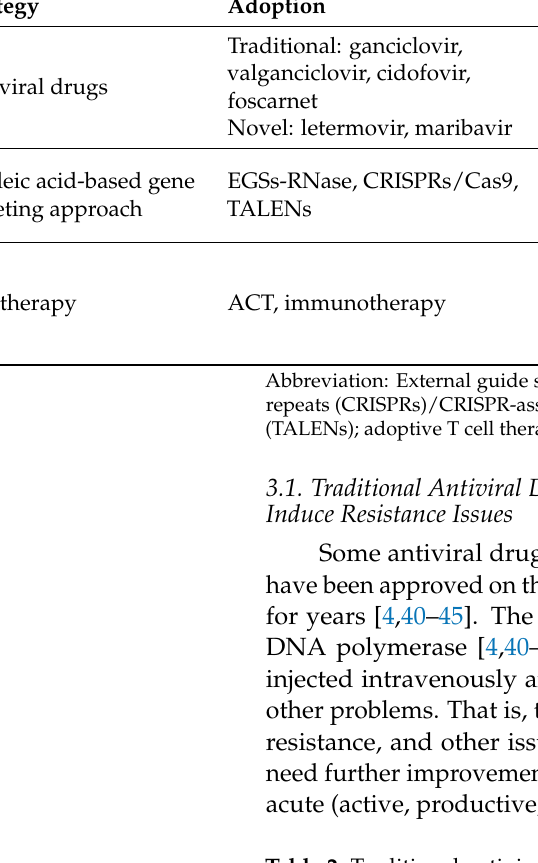
Table 2. Traditional antiviral drugs approved for the treatment of HCMV acute